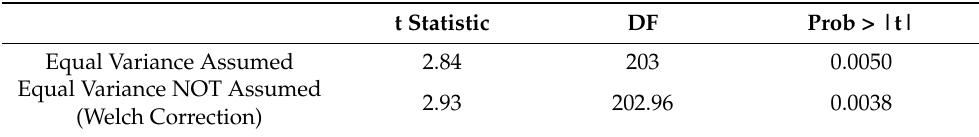
Table 4. The paired-sample t -test of the dislocation loop size distribution in both alloys with a threshold of 2 nm. t Statistic DF Prob > |t| Equal Variance Assumed 2.84 203 0.0050 Equal Variance NOT Assumed 2.93 202.96 (Welch Correction)